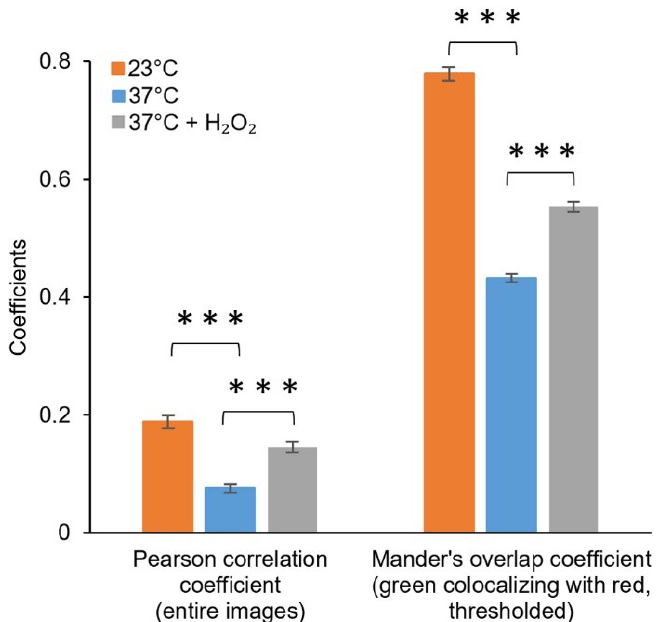
Figure 6. Colocalisation of the fluorescence signals from the green channel (CellROX) and red channel (pJ404-IscR-C/E2-Crimson) acquired under control conditions and oxidative stress-inducing conditions. Fluorescence intensities from the entire confocal microscopy images were used for calculating the Pearson correlation coefficient, while the Manders’ colocalisation coefficients (only M1 shown) were calculated using threshold images. The differences between the samples are statistically significant, with p ≤ 0.001 (***).